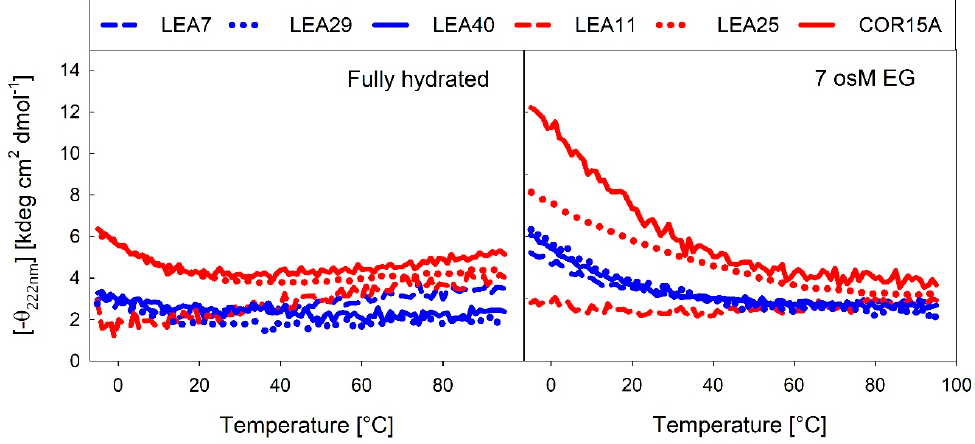
Figure 11. Temperature-dependent changes in α -helicity of the LEA_4 proteins, expressed as the negative ellipticity at 222 nm under fully hydrated conditions ( A ) and in 7 osM EG ( B ). In the fully hydrated state, a temperature increase above room temperature (RT) induced a small degree of α -helical structure, which has been reported for IDPs previously [47]. This was apparent in COR15A, LEA11 and LEA7. As expected, at 7 osM EG, a temperature increase above RT resulted in